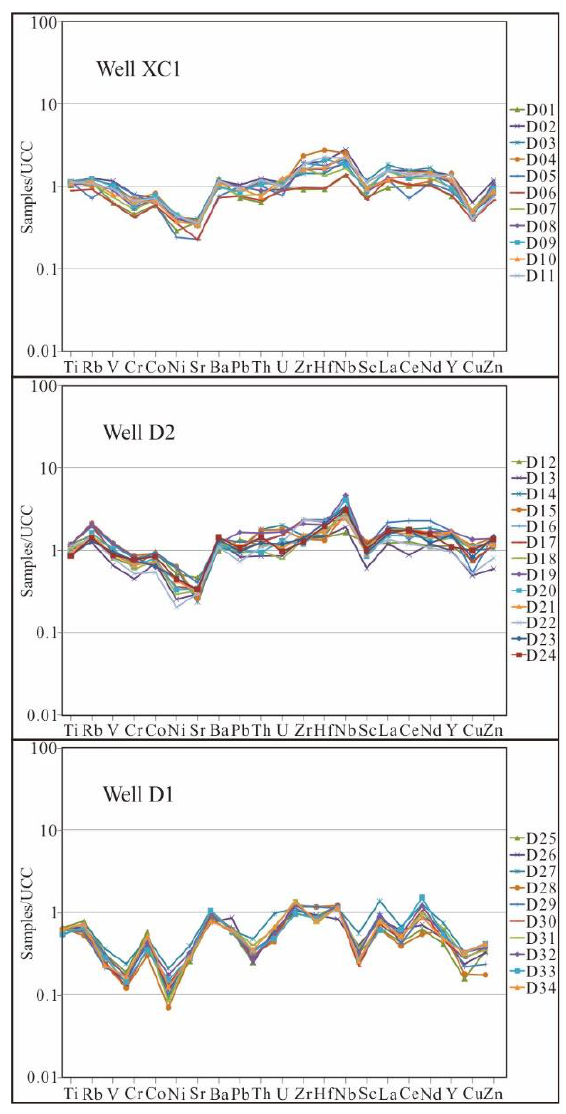
Figure 5. UCC − normalized trace element spidergrams of the samples.